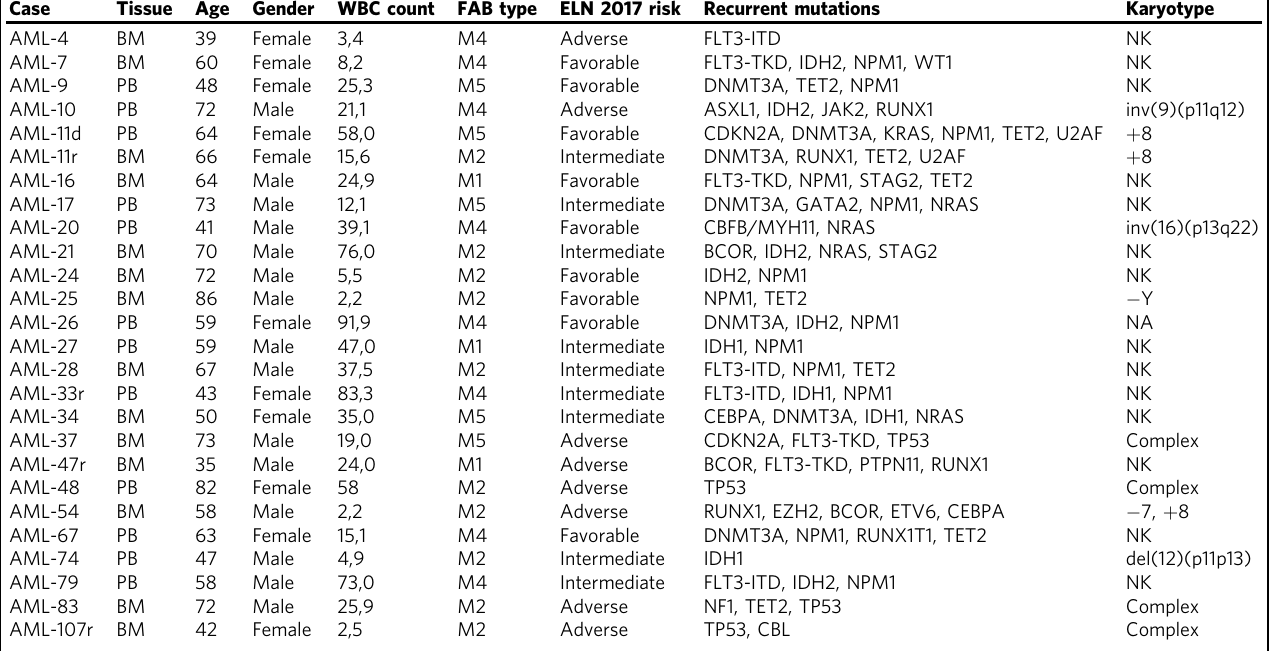
Table 1 Patient characteristics of transplanted AML cases. Case Tissue Age Gender WBC count FAB type ELN 2017 risk Recurrent